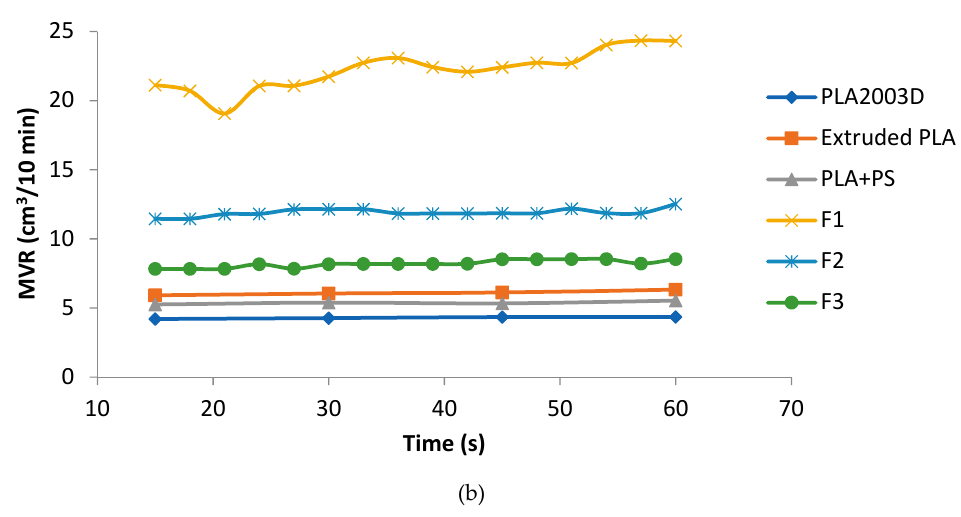
Figure 1. ( a ) Torque as a function of time; ( b ) MVR as a function of time.